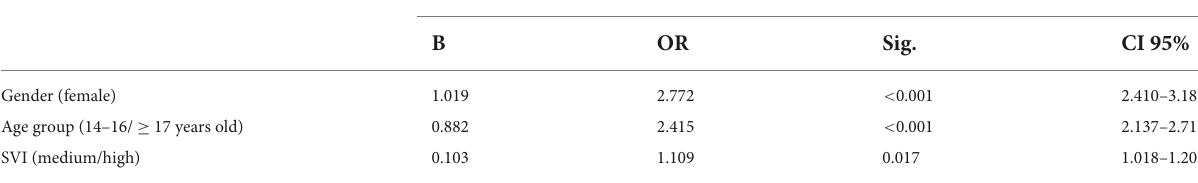
TABLE 3 Factors associated with physical activity habits bellow World Health Organization (WHO)